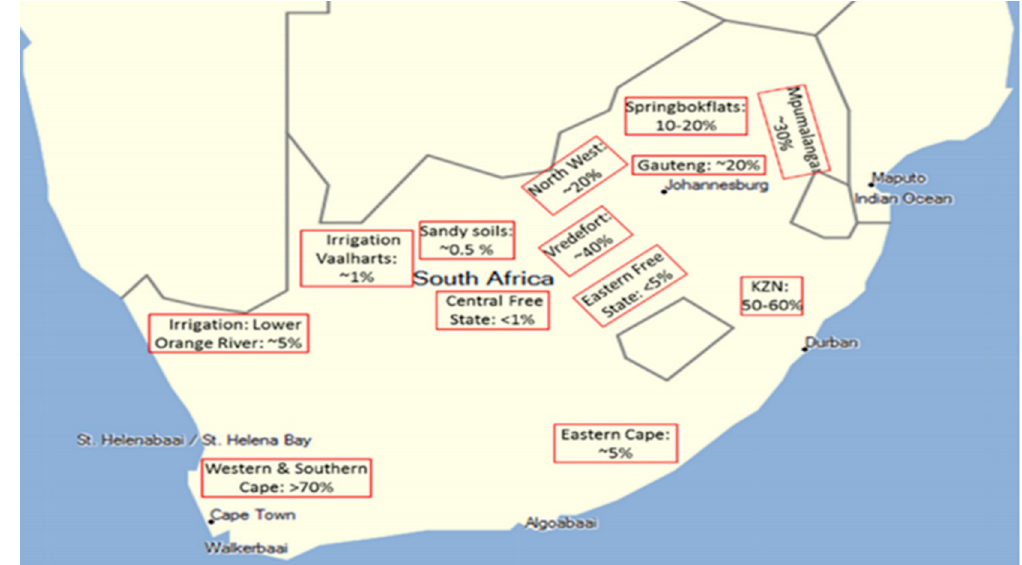
Figure 5. An estimate of CA adoption in South Africa [15].